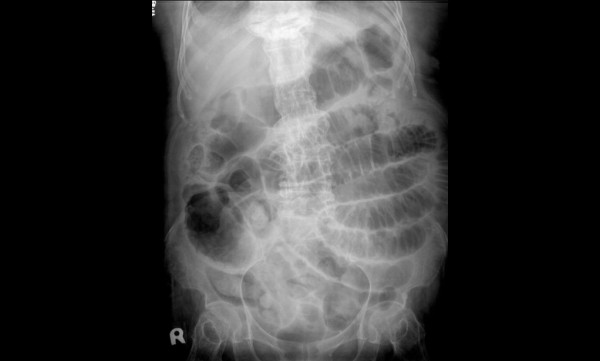
Abdominal roentography taken during the admission screen revealed dilated bowel. loops with air accumulation in the whole abdomen.